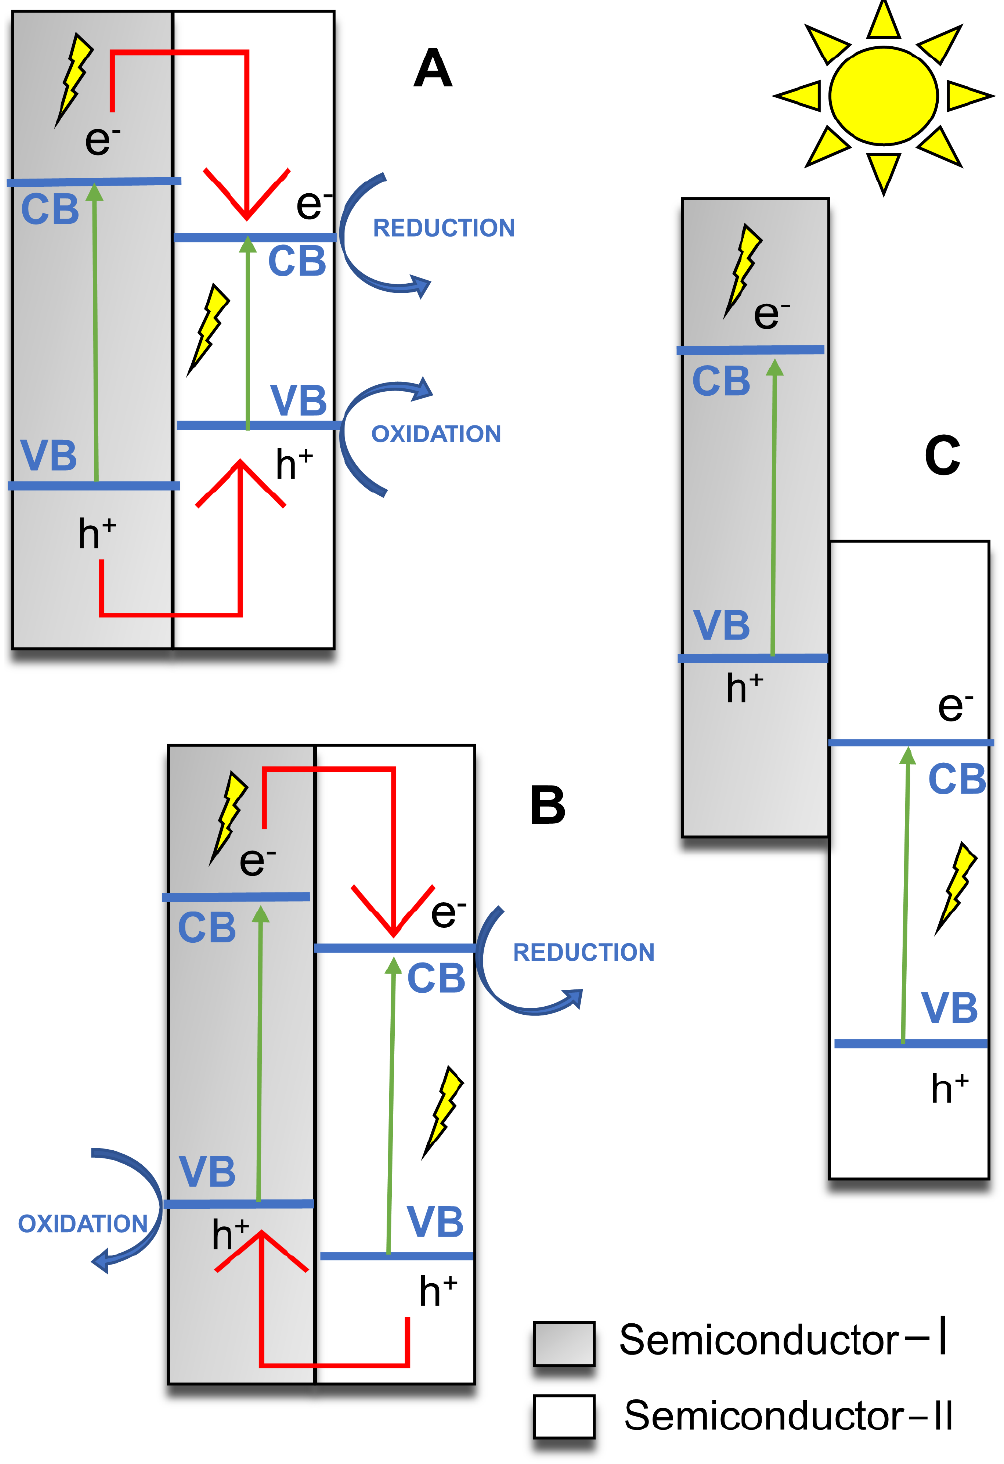
Figure 9. Progression of the Z scheme in photocatalysis, including ( A ) type I, straddling gap, ( B ) type II, staggered gap, and ( C ) type III, broken gap [89]. Adapted with permission from Wiley-VCH Verlag GMBH & CO. KGAA, Advanced Materials , Heterojunction Photocatalysis, Low J. et al., License Number: 1270478-1, 2017.